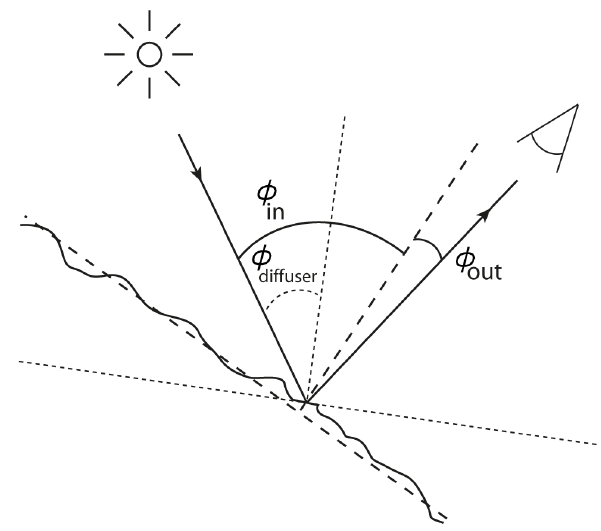
Figure 3. Angle definitions used in the mirror model for diffuser geometries. Solid curves with arrows indicate the light beam of in- terest with direction; long dashed curves indicate the macro-scale surface of the diffuser and its normal. Short dashed curves indi- cate the extrapolated surface and normal of the facet that causes the specular reflection of the light beam of interest. The various random (micro-scale) facets of the diffuser are indicated by the wiggly solid curve. Only facets oriented such that they cause specular reflection in the direction of the instrument contribute to the signal, dictat- ing relative polarisation behaviour. Unpolarised reflectivity is only a function of the angular distribution of the facets of the diffuser, and the orientation of the diffuser in the light